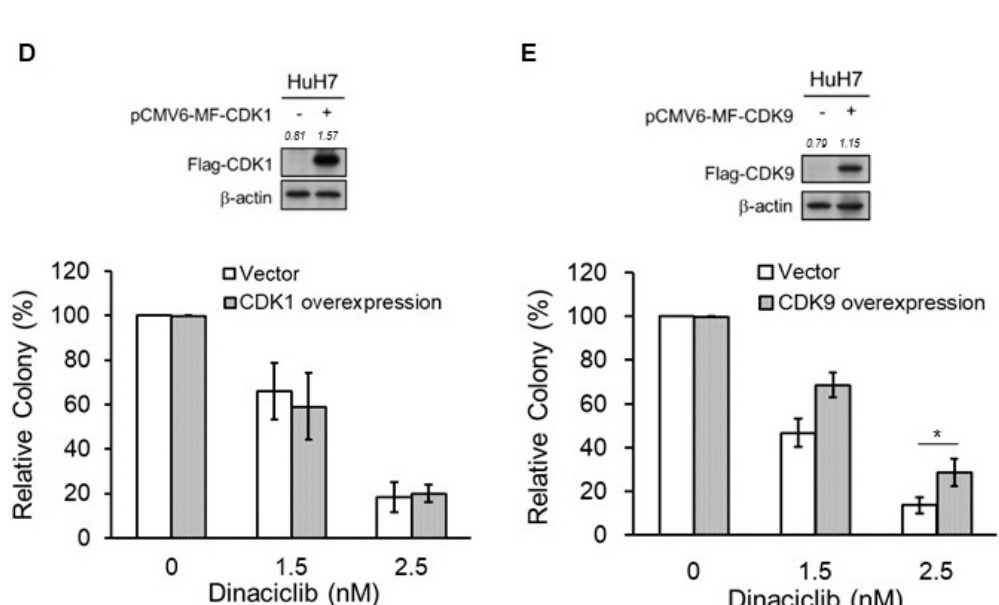
Figure 5. ( A ) Western blot analysis results indicating the expression of various CDKs and their downstream molecules after transfection with siRNAs for 72 h. Nontarget (NT) siRNA served as a negative control. ( B , C ) Colony formation assay. After transfection with the indicated siRNAs for 24 h, the cells were seeded and incubated for 14 days. Data are presented as the colony number relative to that of HuH7 cells treated with NT siRNA. * denotes statistical significance of the comparisons between the two manipulations (n.s. = not significant). ( D , E ) Colony formation assays. Cells were transfected with the vector overexpressing CDK1 ( D ) or CDK9 ( E ) and then incubated with dinaciclib at the indicated concentration. * denotes statistical significance of the comparisons between the two